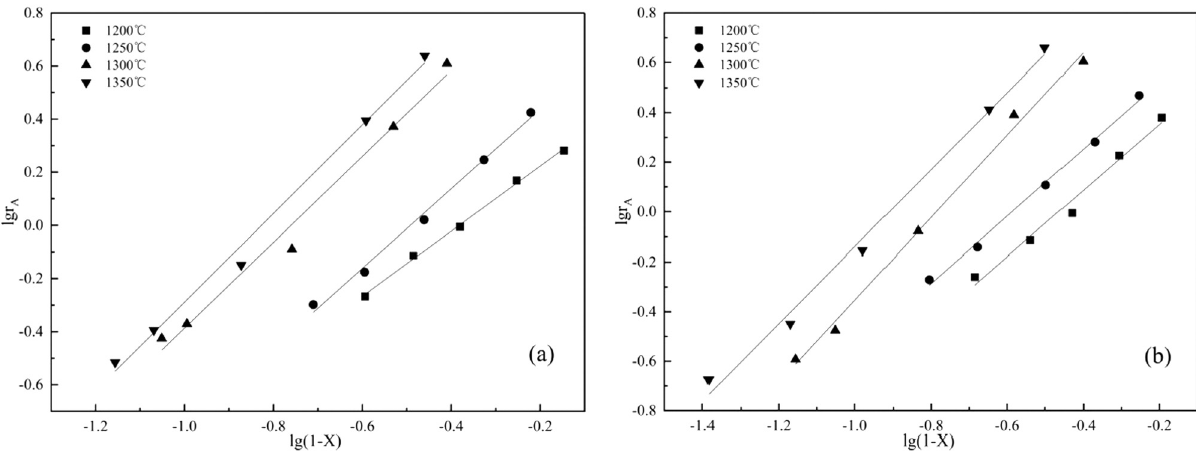
Figure 7: Fitting plots of log r A and log ( 1 − X ) at di ff erent temperatures: ( a ) SiO 2 , ( b ) fl y ash.